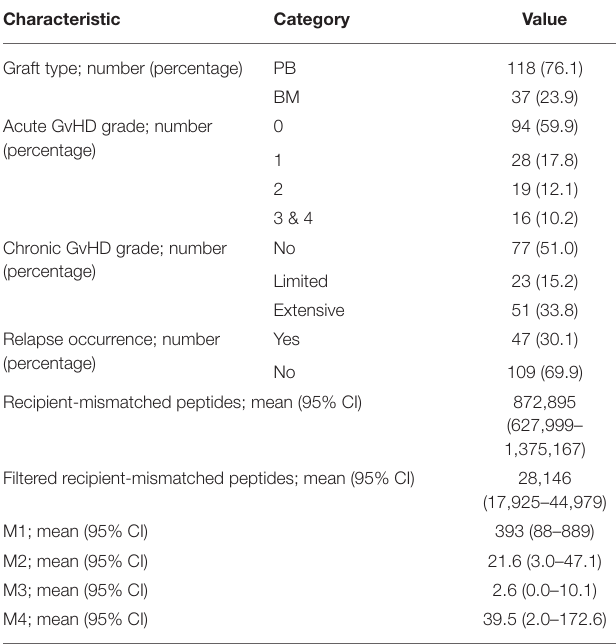
TABLE 1 | General characteristics of the study